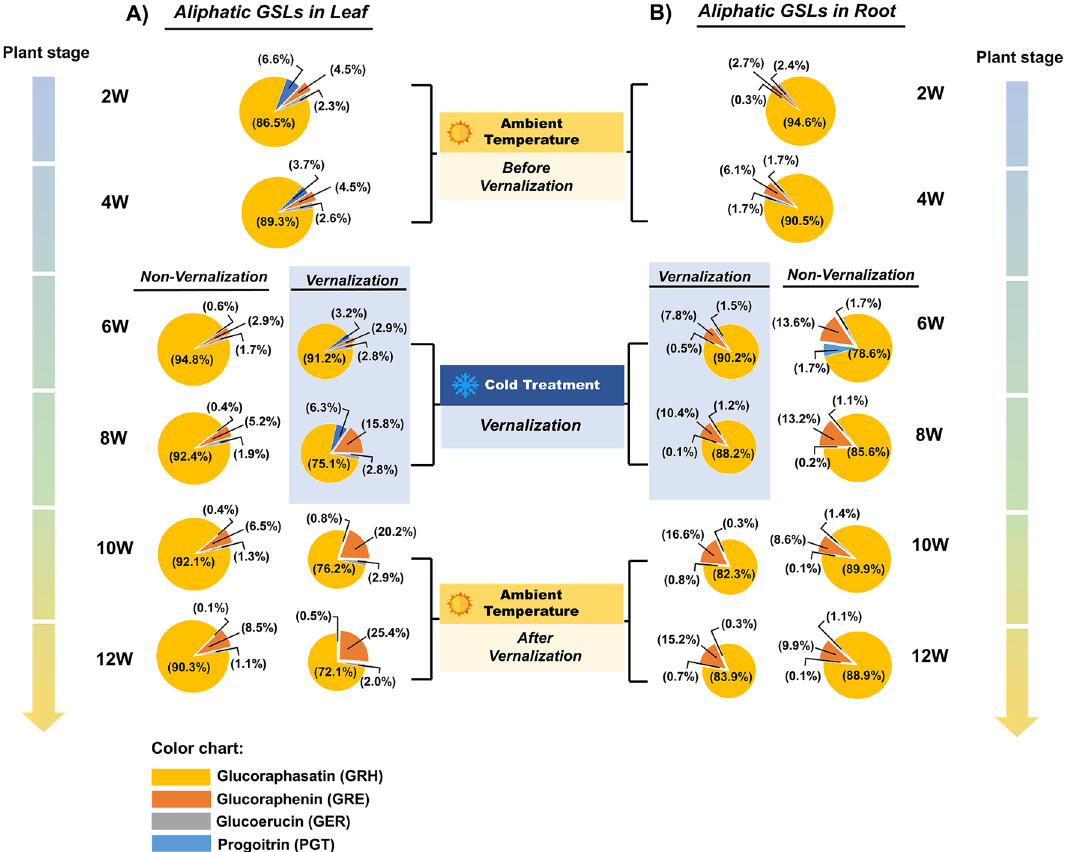
Figure 3. The aliphatic GSLs content and profiles of the leaves ( A ) and roots ( B ) of vernalized and non- vernalized R. sativus . The smaller size of pie-graph for the vernalization group indicated lower total aliphatic GSLs content compared with the non-vernalization group. Data were presented as mean ± standard deviation (SD) (n = 3). Statistically significant differences were determined by one-way ANOVA and Tukey’s post hoc test ( p < 0.05). PGT Progoitrin, GRE Glucoraphenin, GER Glucoerucin, GRH